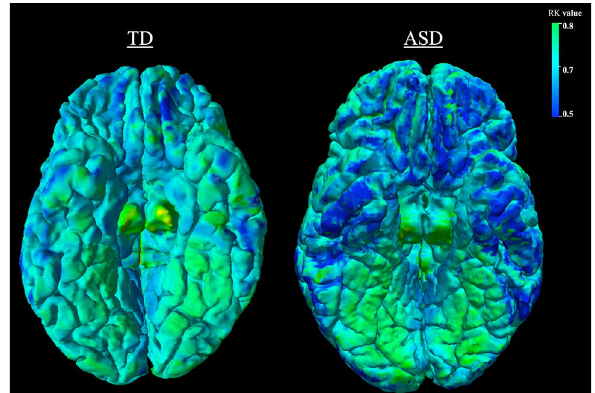
Figure 4. Surface map of radial kurtosis values in a typically developing versus an autism spectrum disorder participant from an inferior view of the temporal, frontal and cingulate areas. RK values are projected from a middle GM cortical layer depth. Dark blue indicates lower values, while bright green indicates higher values.